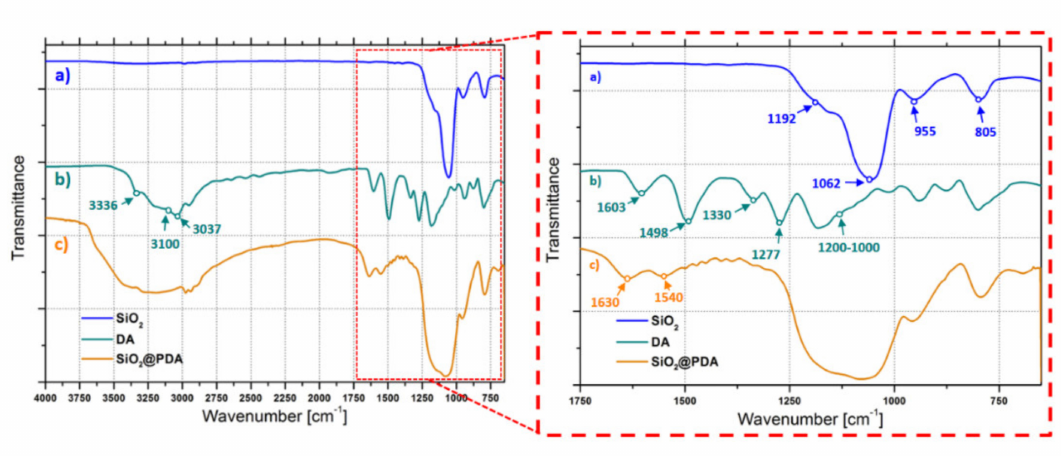
Figure 2. ATR–FTIR spectra of ( a ) pristine silica NPs, ( b ) DA and ( c ) SiO 2 @PDA.